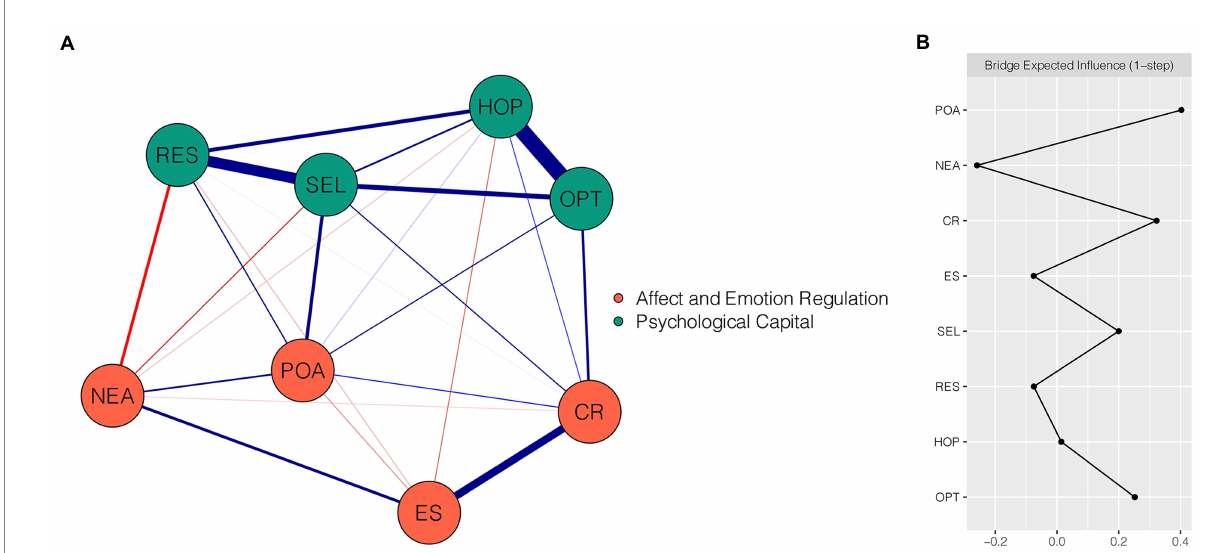
FIGURE 1 Network structure of emotion regulation, affect, and PsyCap dimensions. (A) EBICglasso network, where blue edges represent positive correlations and red edges represent negative correlations. A thicker edge reflects a higher correlation between nodes. (B) Centrality plot depicting the bridge expected influence of each node in the network (raw value). CR, cognitive reappraisal; ES, expressive suppression; POA, positive affect; NEA, negative affect; SEL, self-efficacy; RES, resilience; HOP, hope; OPT, optimism.